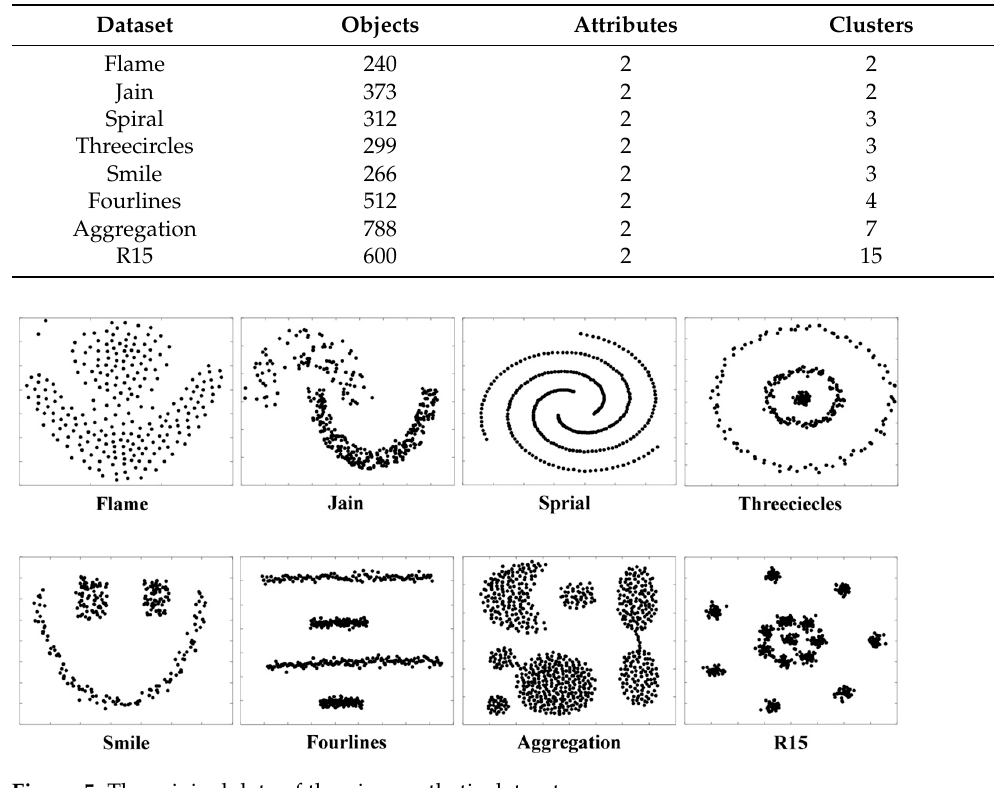
Figure 5. The original data of the nine synthetic datasets. As shown in Figure 6, only the TP-DSDPC algorithm is completely effective for the Flame dataset. DPC and KNN-DPC cannot identify some noise points and boundary points. DGDPC does not recognize the junction points of two clusters. It can be seen from Figure 7 that TP-DSDPC is able to excellently cluster the Jain dataset. From the clustering results revealed in Figure 8, aside from K-means and the original DPC, others are processed well for clusters of the Spiral dataset.